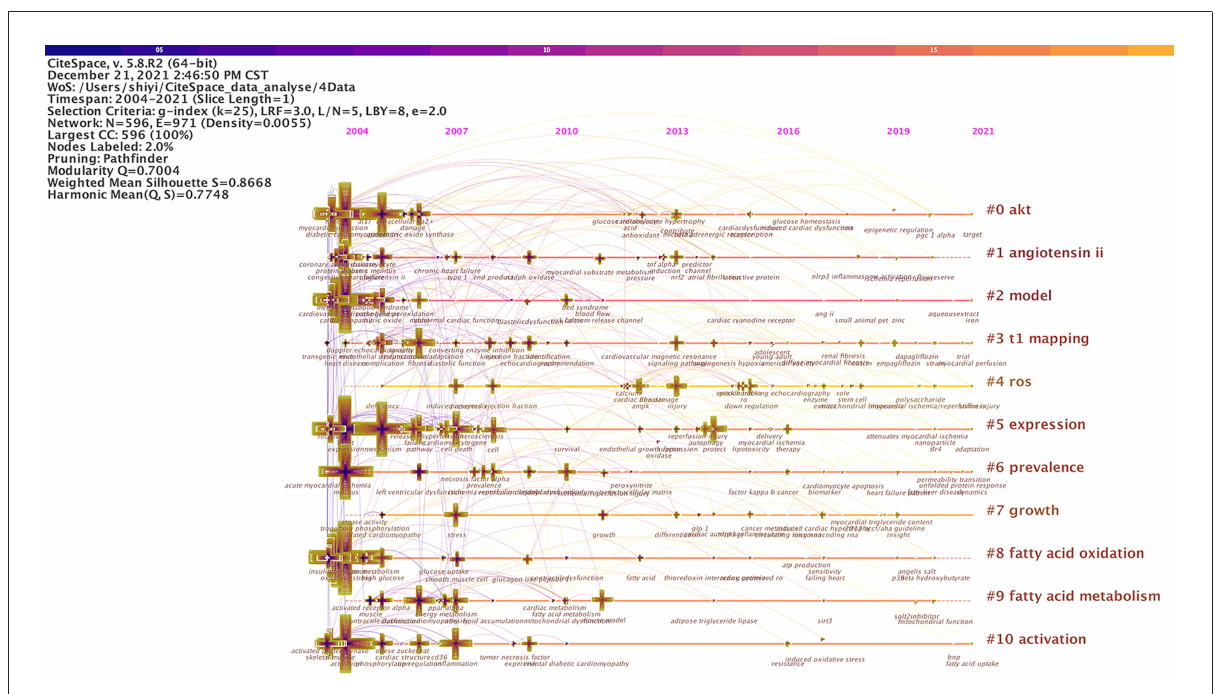
FIGURE6 Recurring cardiomyopathy research after Figure 5 data are sorted into chronological order.